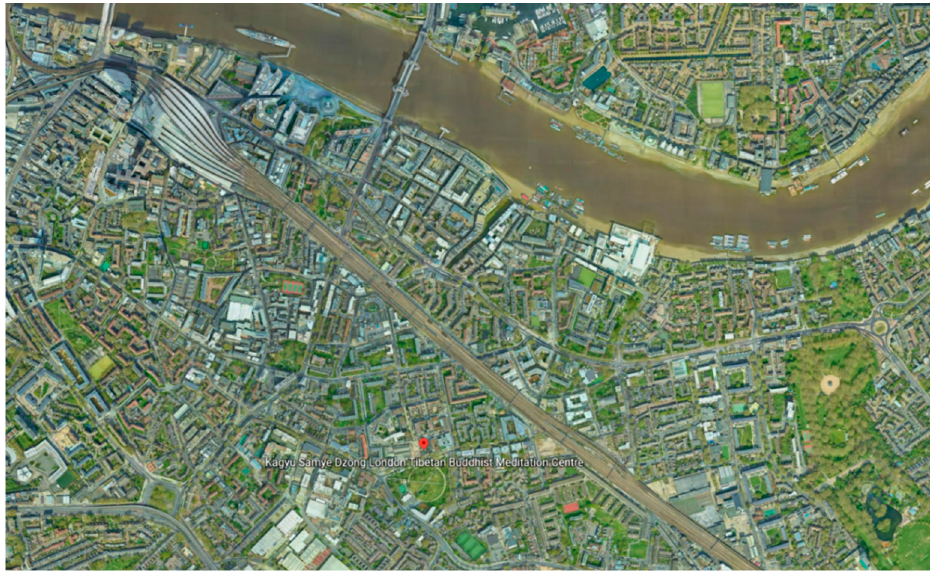
Figure 3. Map with location of Kagyu Samye Dzong, London (source: Google Earth) .